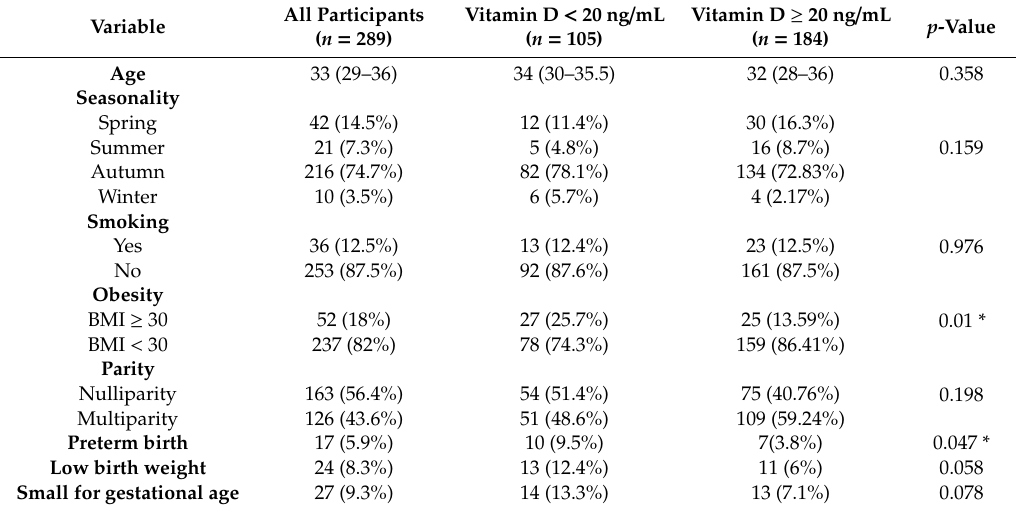
Table 1. Characteristics of participants based on 25-hydroxyvitamin D cut-o ff points.